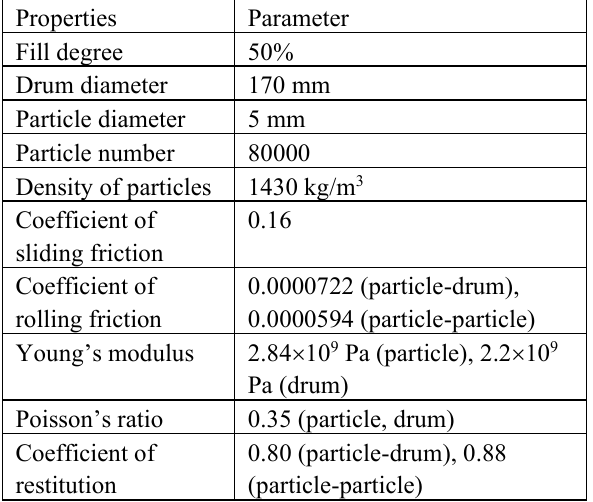
Table 1. Material properties and parameters used in the